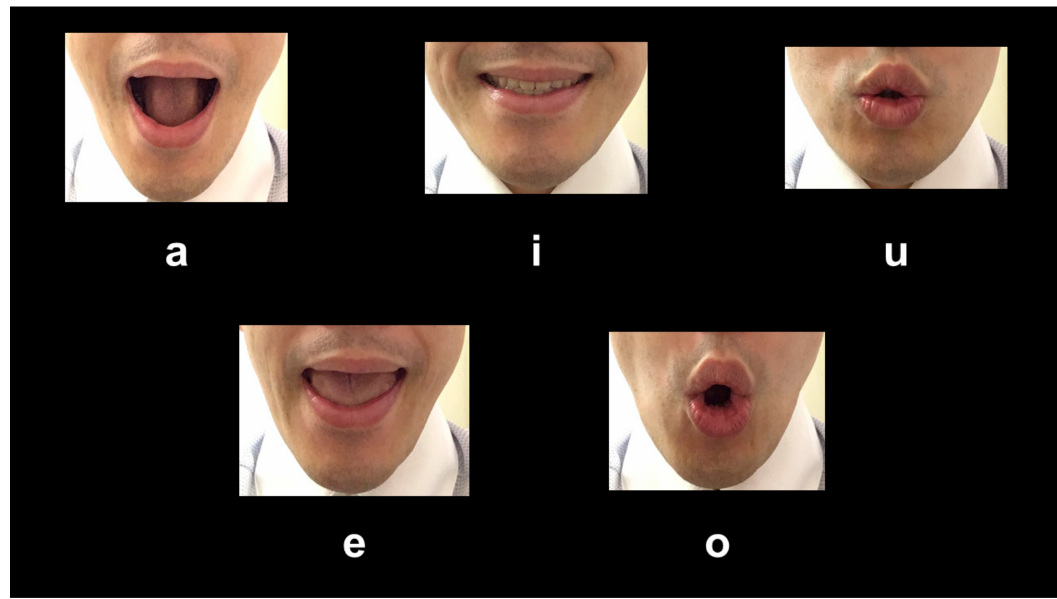
Figure 1. Five mouth shapes studied that voice a Japanese